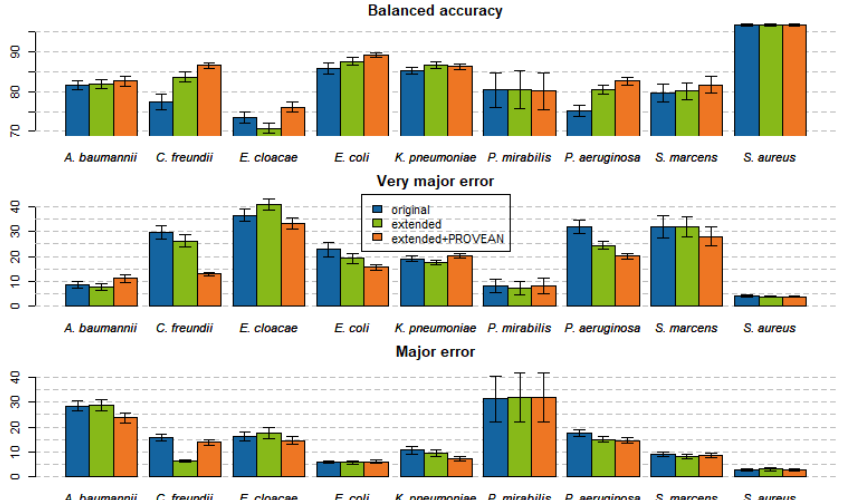
Figure 1. Balanced accuracy, very major error (1-sensitivity), and major error (1-specificity) of trained models as averaged across the compounds of the given pathogens. Error bars are the standard error of means.